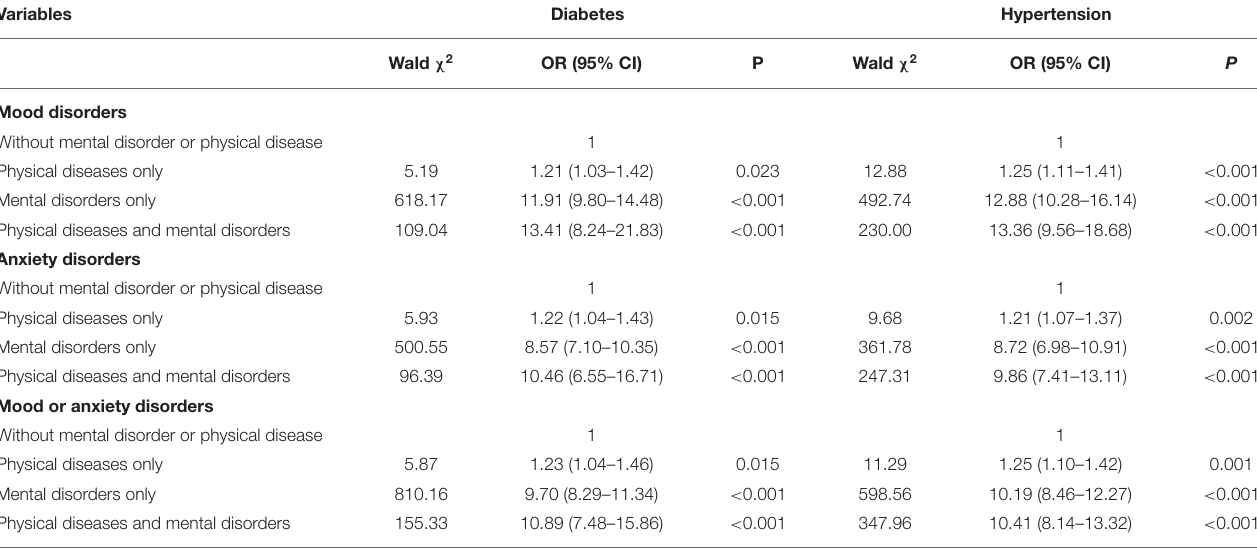
TABLE 5 | The association of comorbidity with current disability *